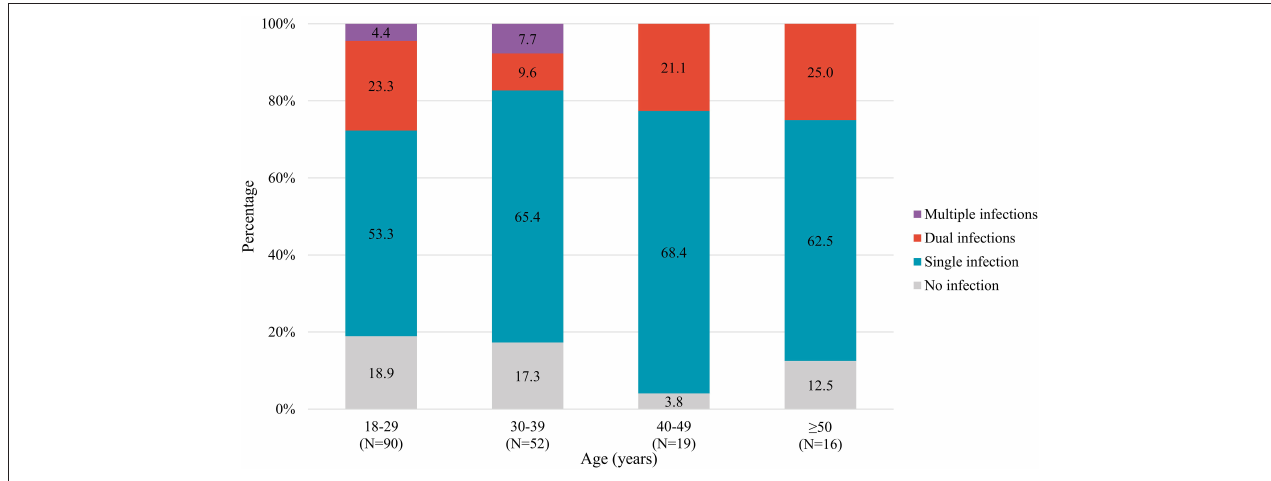
FIGURE 4 | STI co-infections patterns stratified by age groups among 177 MSM. STI, sexually transmitted infection; MSM, men who have sex with